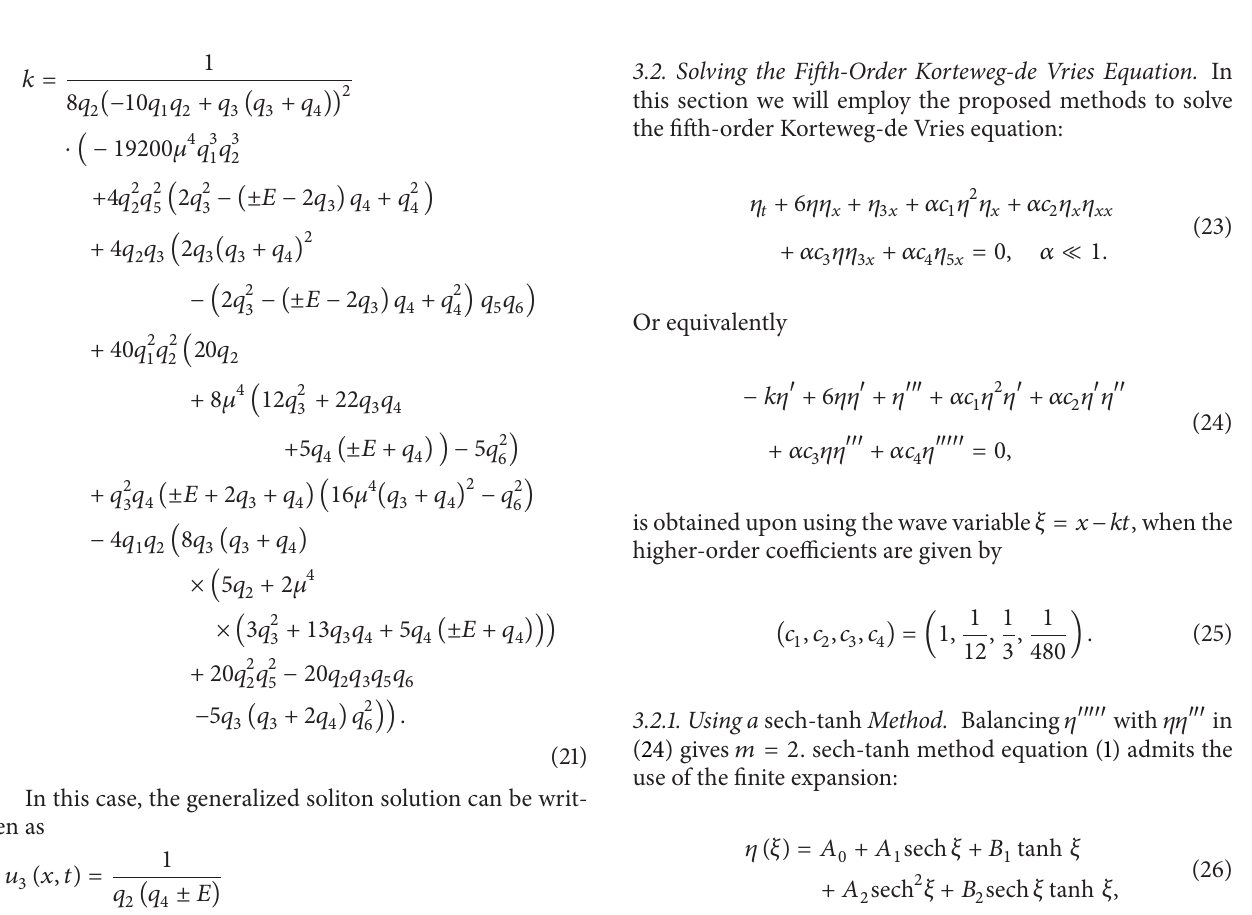
Figure 2: (a) Travelling waves solutions of (18) is plotted: stability dark solitary waves. (b) Travelling waves solutions of (18) is plotted: stability contour of solitary